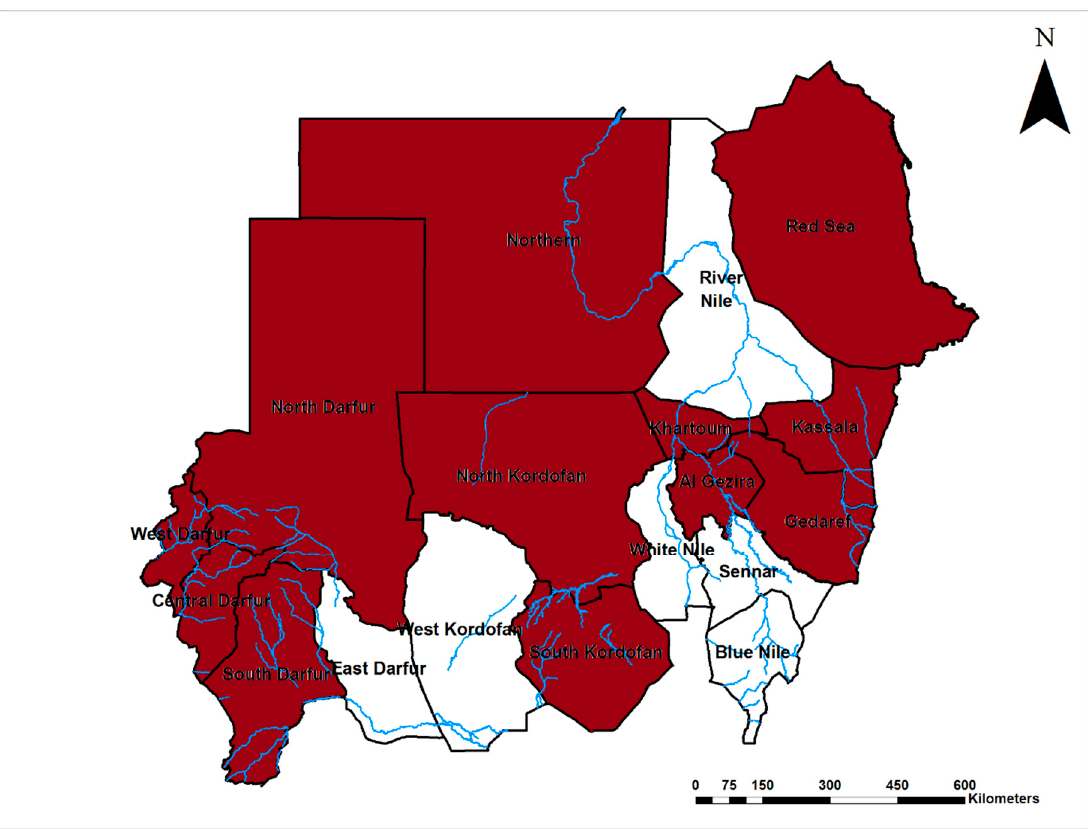
Figure 2. Map of Sudan showing the prevalence of dengue fever virus infections (Brown).